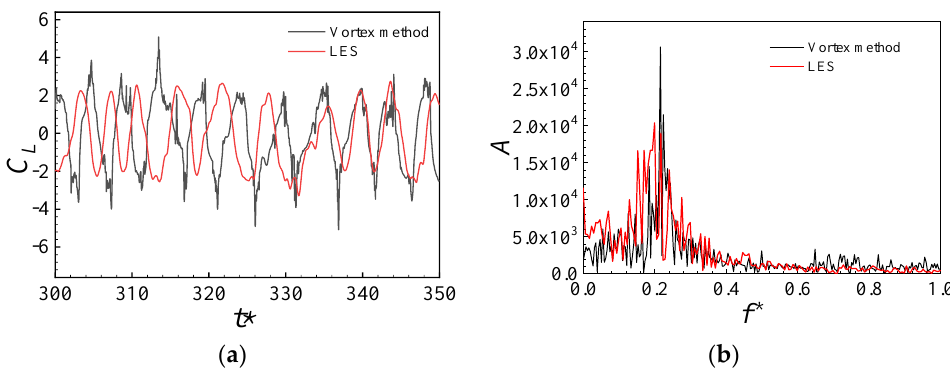
Figure 2. Lift coefficient and related amplitude spectrum: ( a ) Lift coefficient; ( b ) Amplitude spectrum.